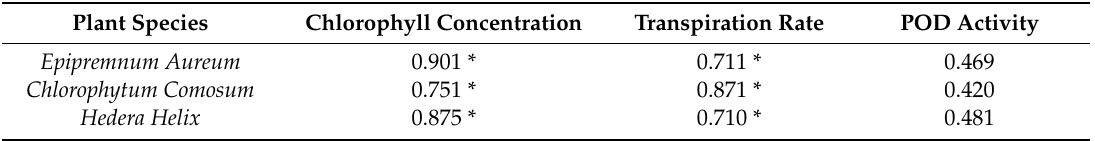
Table 4. Correlation coe ffi cients between chlorophyll concentration, transpiration rate and POD activity, and benzene removal rate in di ff erent plants.